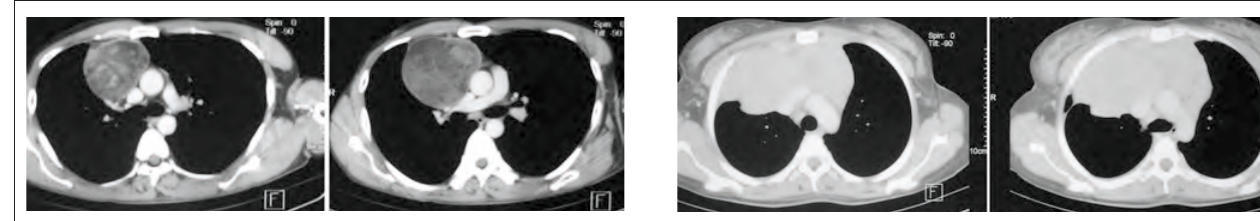
Fig. 10. Axial CT image in a 24-year-old woman showing homogenously enhancing anterior mediastinal mass in a case of seminomatous germ cell tumour.